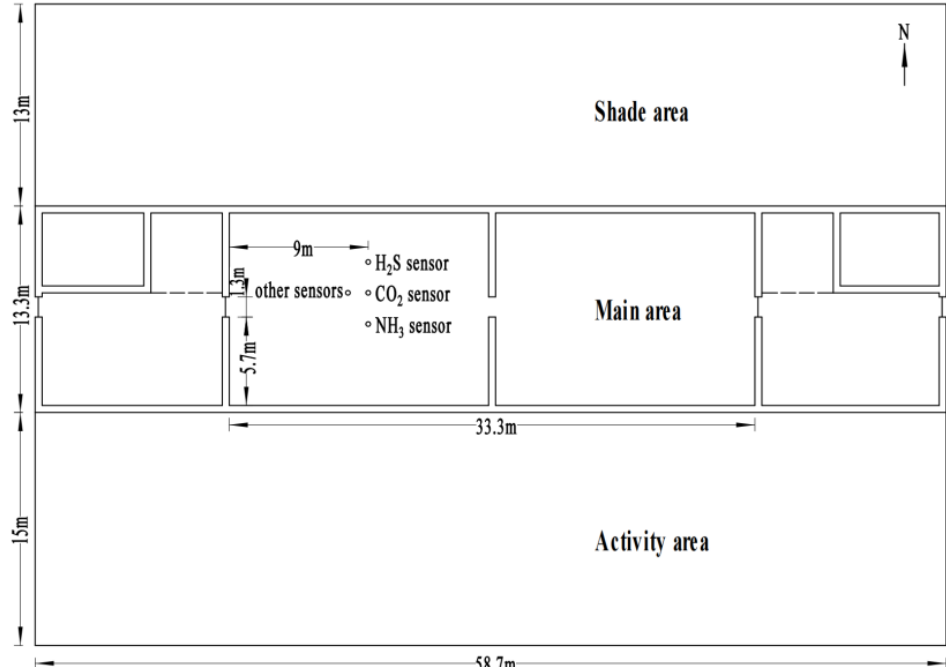
Figure 1. Schematic diagram of sensor installation position.